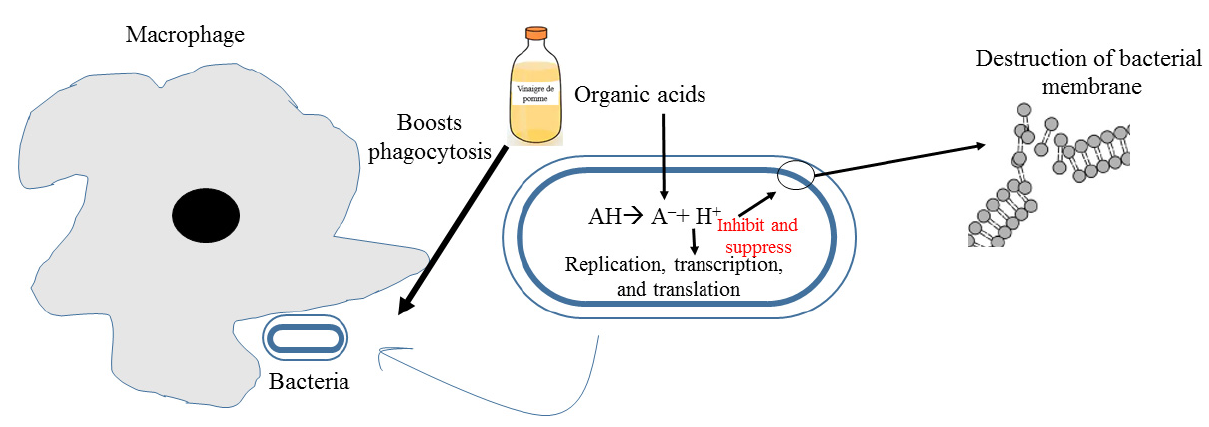
Figure 2. Mechanism of action possible of apple vinegar against pathogenic